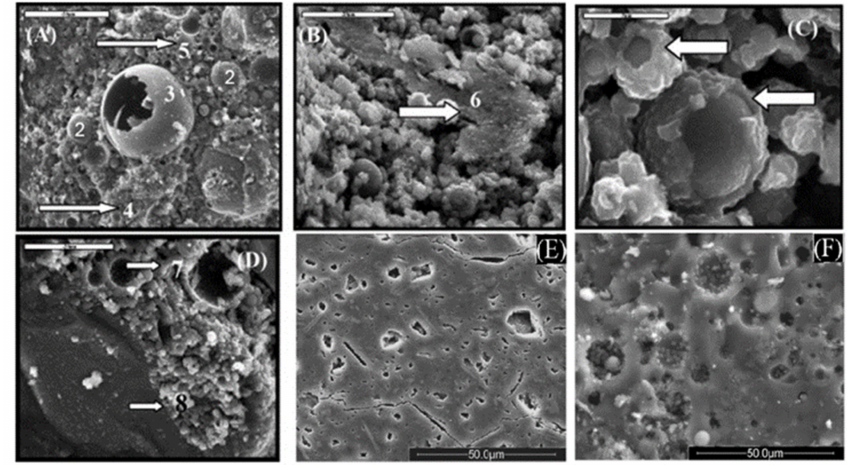
Figure 7. SEM micrographs of FA and MK-based geopolymers: FA morphology ( A ), zeolitic crys- talline phase on the source materials ( B , D ), FA particles not completely covered by the reaction product ( C ), microstructures of MK-based geopolymer ( E ), and microstructure of FA-based geopoly- mer ( F ). Reprinted with permission from Ref [49]. Copyright 2016 IOP Publishing. Nath et al. [50] presented a detailed SEM analysis on the microstructure evolution of FA-based geopolymer binders following the change in alkali concentration and curing temperature. The micrographs are reported in Figure 8.